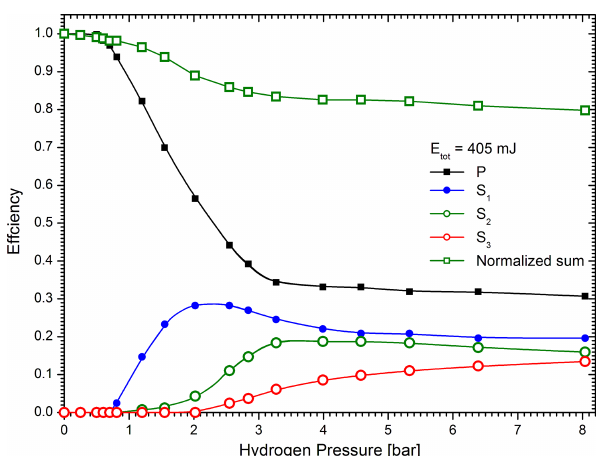
Figure 2. Overview of the mobile ozone DIAL: the laser and the Raman-shifting components were mounted on optical tables at two different levels of a shock-isolated frame. The Newtonian telescope was located in a separate tower, with the secondary mirror directing the beam into a polychromator perpendicularly to the plane formed by the telescope and the outgoing laser beam. The covers of the Ra- man compartment (jalousies on both sides) and the telescope (door) were removed in this simple view. The laser power supply was de- livered in two units custom-made to fit under the lower laser table. The entire frame was rolled into the lorry through the rear doors.